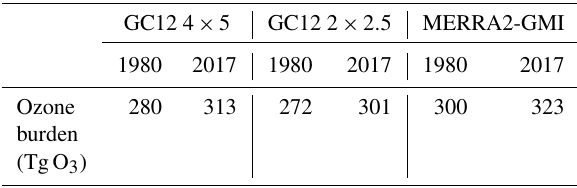
Table 3. Ozone burden in 1980 and 2017, recorded in TgO 3